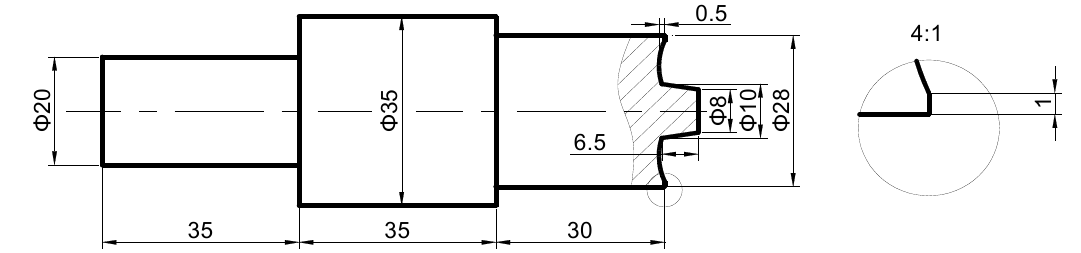
Figure 1. Photograph showing the dimensions of the tool.